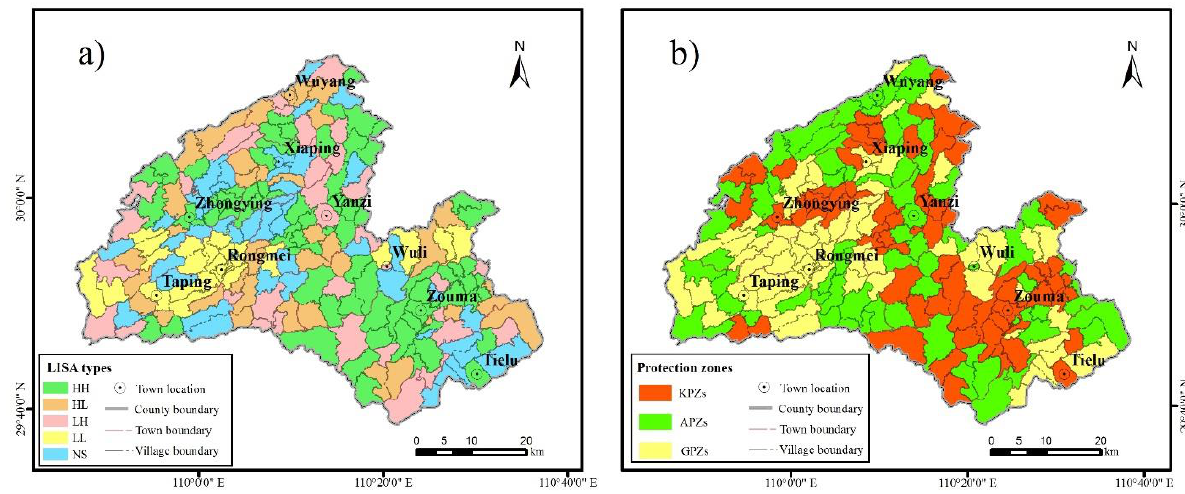
Figure 5. ( a ) Local Indicator of Spatial Association (LISA) type map of forest land quality in Hefeng; ( b ) forest land protection zoning map.